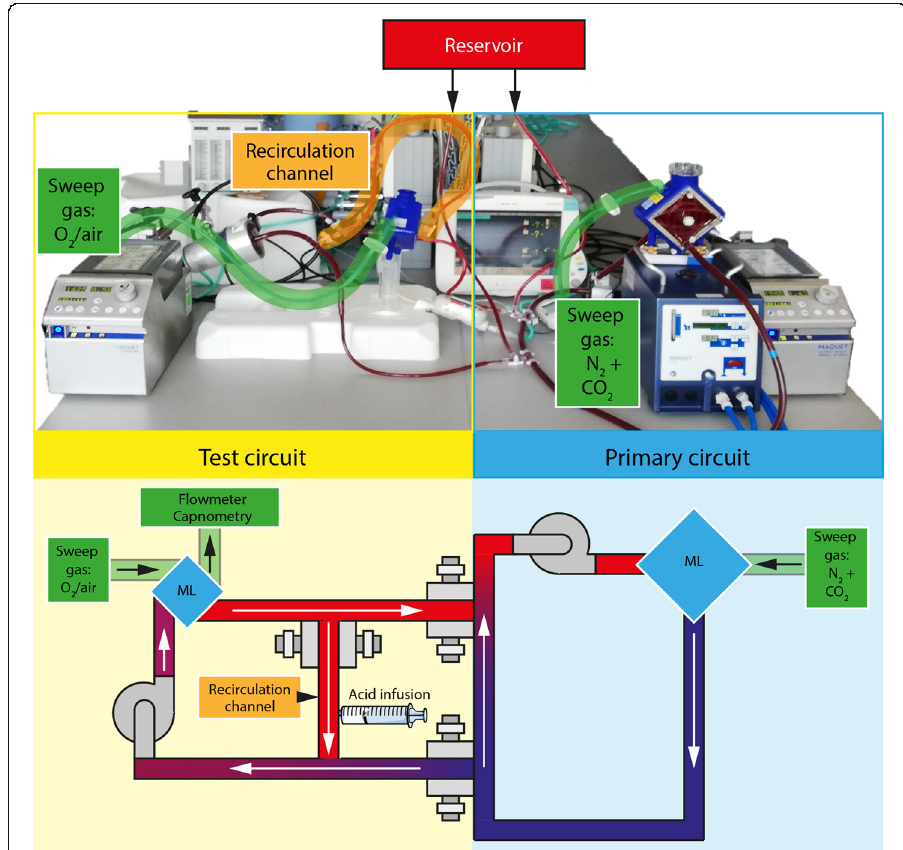
Fig. 1 Schematic layout of the mock. The mock consists of two interconnected circuits with one membrane lung (ML) each. The primary circuit represents the simulated organism. It has a blood flow of 5 L/min and creates a hypoxic and hypercapnic (venous) environment with N 2 and CO 2 as sweep gases. The actual ECCO 2 R setup to be evaluated is built into the test circuit. CO 2 removal over the ML in the test setup is quantified. In this work, the influence of different hemoglobin concentrations (12, 7, and 4 g/dL), different sweep gases (O 2 vs. air), and low-flow scenarios (blood flow amplification with recirculation channel, acidification of recirculated blood) on CO 2 removal are